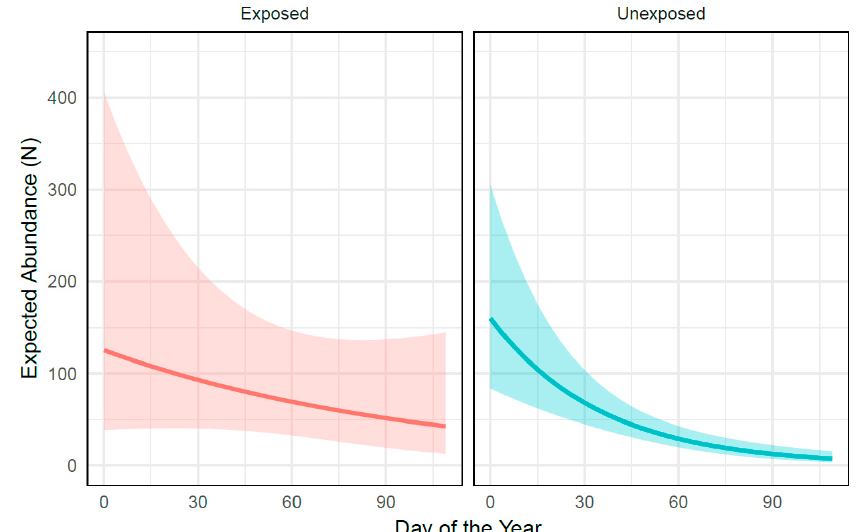
Figure 3. Model estimates of expected abundance ( λ exposed/unexposed ) as a function the number of days since the first survey (day 0 : 11 May 2018) separated out by exposure category ( left : exposed, right : unexposed). Bold lines are maximum likelihood estimates, and shaded polygons are the 95% confidence intervals.